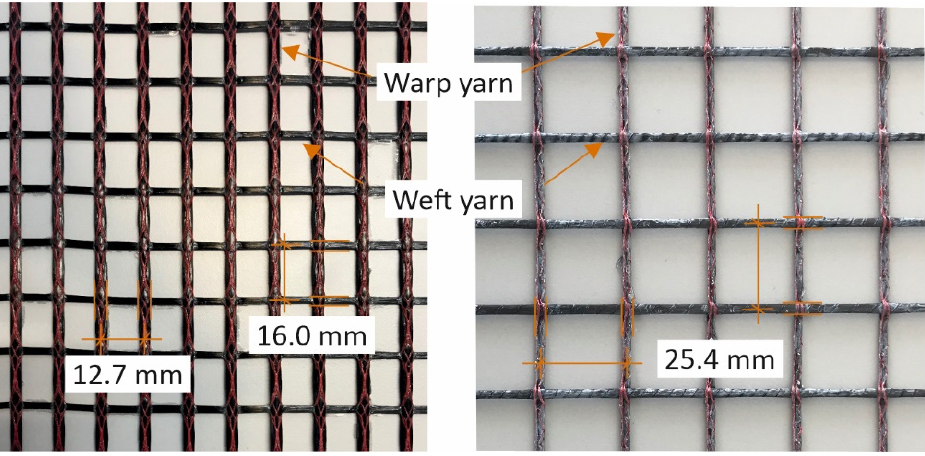
Figure 3. Possible carbon grid geometries. (Photo: CARBOCON GMBH). Table 2. Permitted range of geometric properties of the CARBOrefit ® -grid standard design and special design, according to [30].